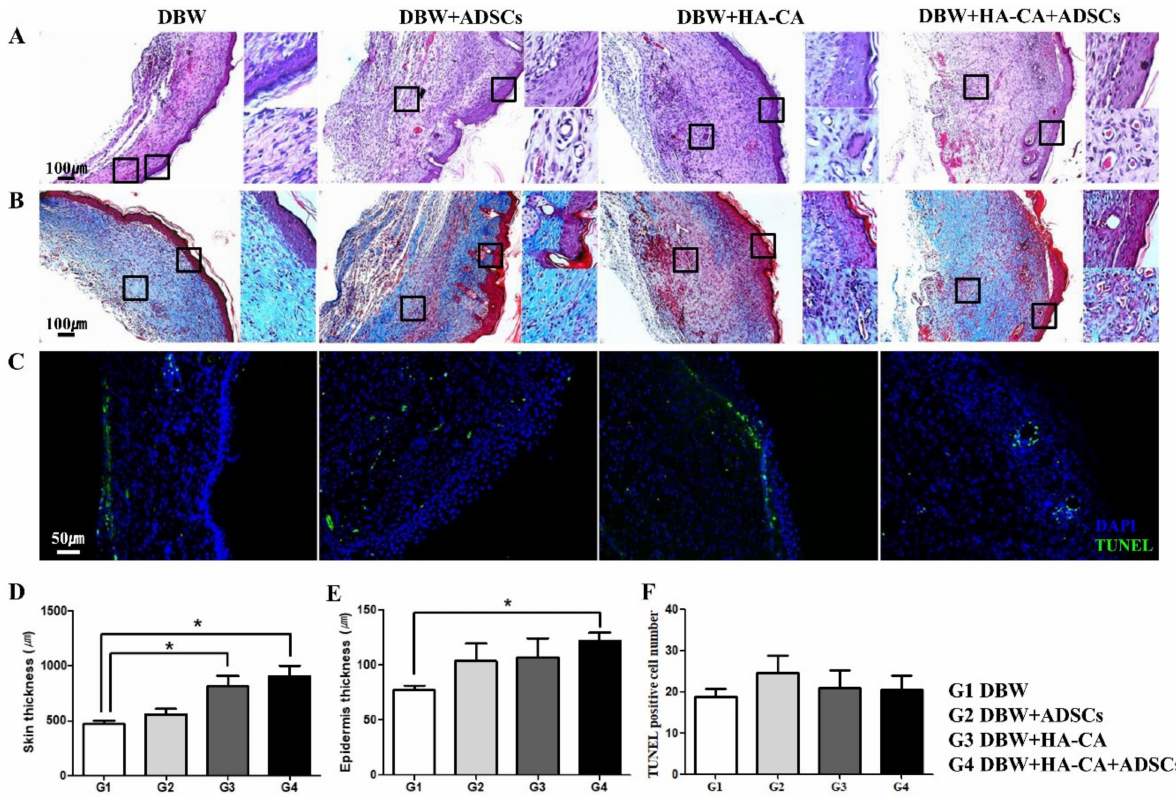
Figure 2. Histopathological analysis of the diabetic wounds. ( A ) Skin tissue sections were stained with hematoxylin and eosin (H&E) on POD 21. The epidermis was regenerated in all groups; however, the dermis and subcutis were not regenerated in the control DBW group. Blood vessels and epidermal appendages, including sweat glands and hair follicles, were observed in the HA-CA, ADSCs, and HA-CA + ADSCs groups. ( B ) Masson’s trichrome staining showing skeletal muscle (red) regeneration and collagen (blue) deposition in all groups. Compared with the control DBW group, the degree of skeletal muscle regeneration was higher in mice treated with HA-CA and/or ADSCs. ( C ) TUNEL staining was performed to assess apoptosis (green fluorescence). There were no differences in apoptosis among the groups. Magnification: × 100 (H&E, trichrome), × 200 (TUNEL). ( D , E ) Quantification of ( D ) skin thickness and ( E ) epidermis thickness. ( F ) Apoptotic cells were quantified. Data are presented as means ± SEM (* p < 0.05; n = 8–10 per